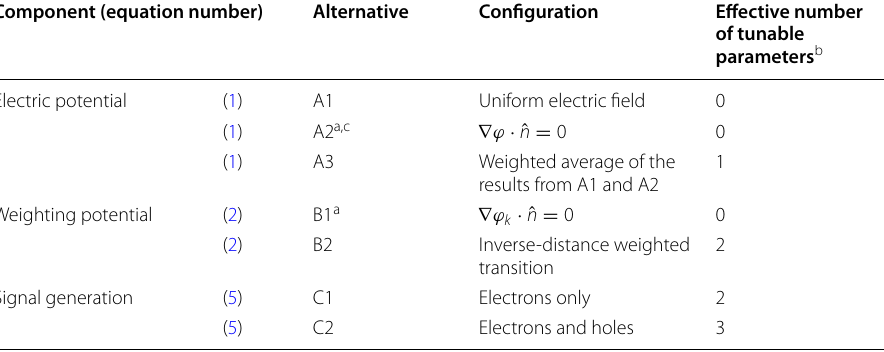
a Boundary condition applied on inter‑anode gaps.